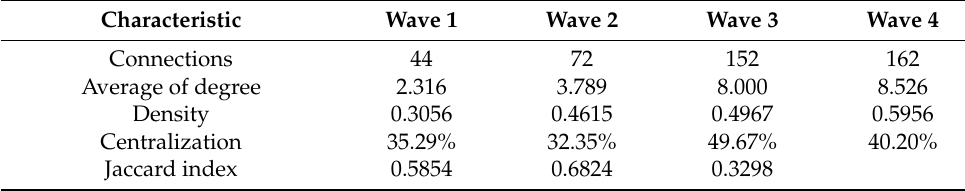
Table 3. Cooperative relationship network descriptive statistics.